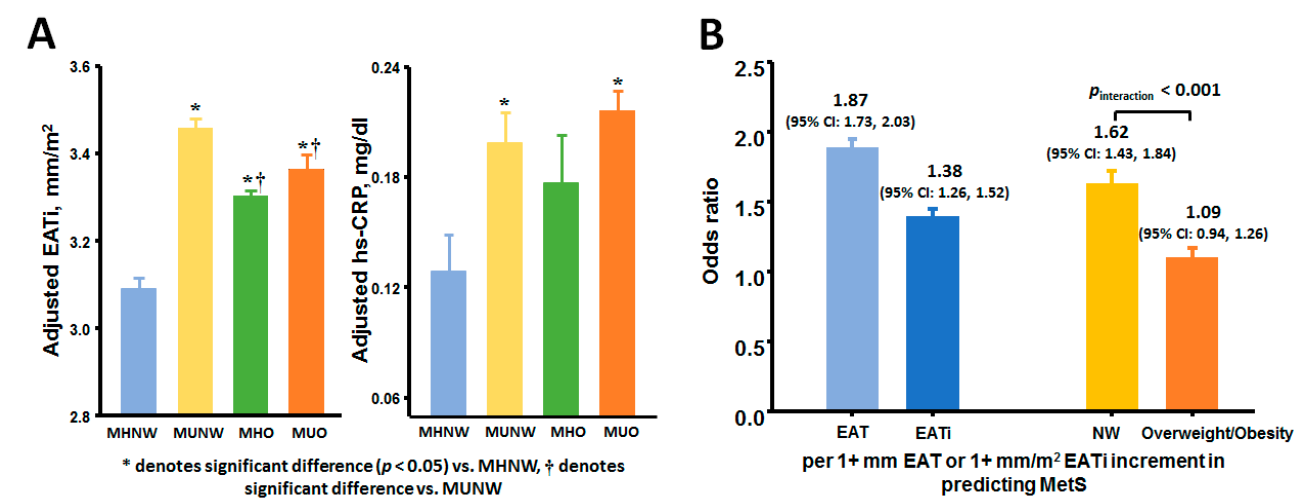
Figure 2. ( A ) Adjusted indexed epicardial adiposity thickness (EATi) and high sensitivity C-reactive protein (hs-CRP) across four obesity phenotypes. ( B ) Logistic regressions demonstrating the presence of metabolic syndrome per 1 mm increase in EAT (as odds ratio) and by body mass index (BMI) strata.